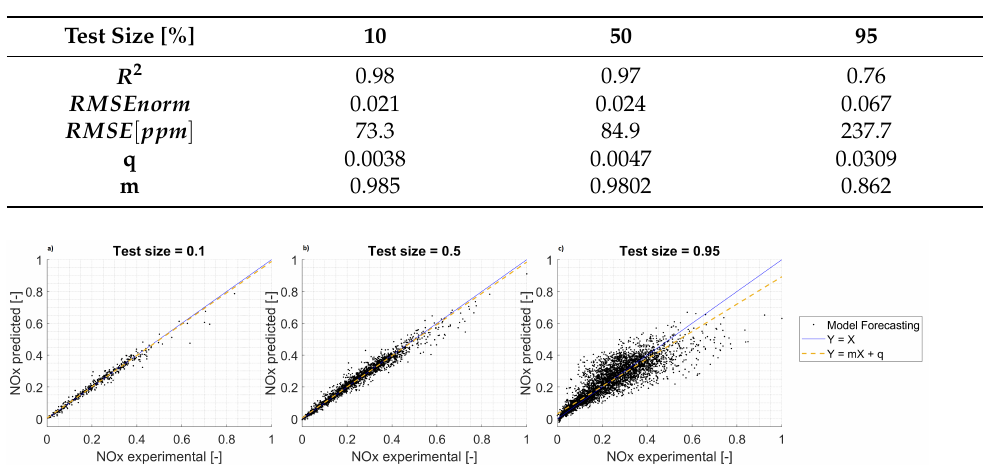
Table 5. Summary of performance prediction results for test case ECU – ECU . The test size is here reported for the sensitivity analysis, considering the different percentage values 10%, 50% and 95%.